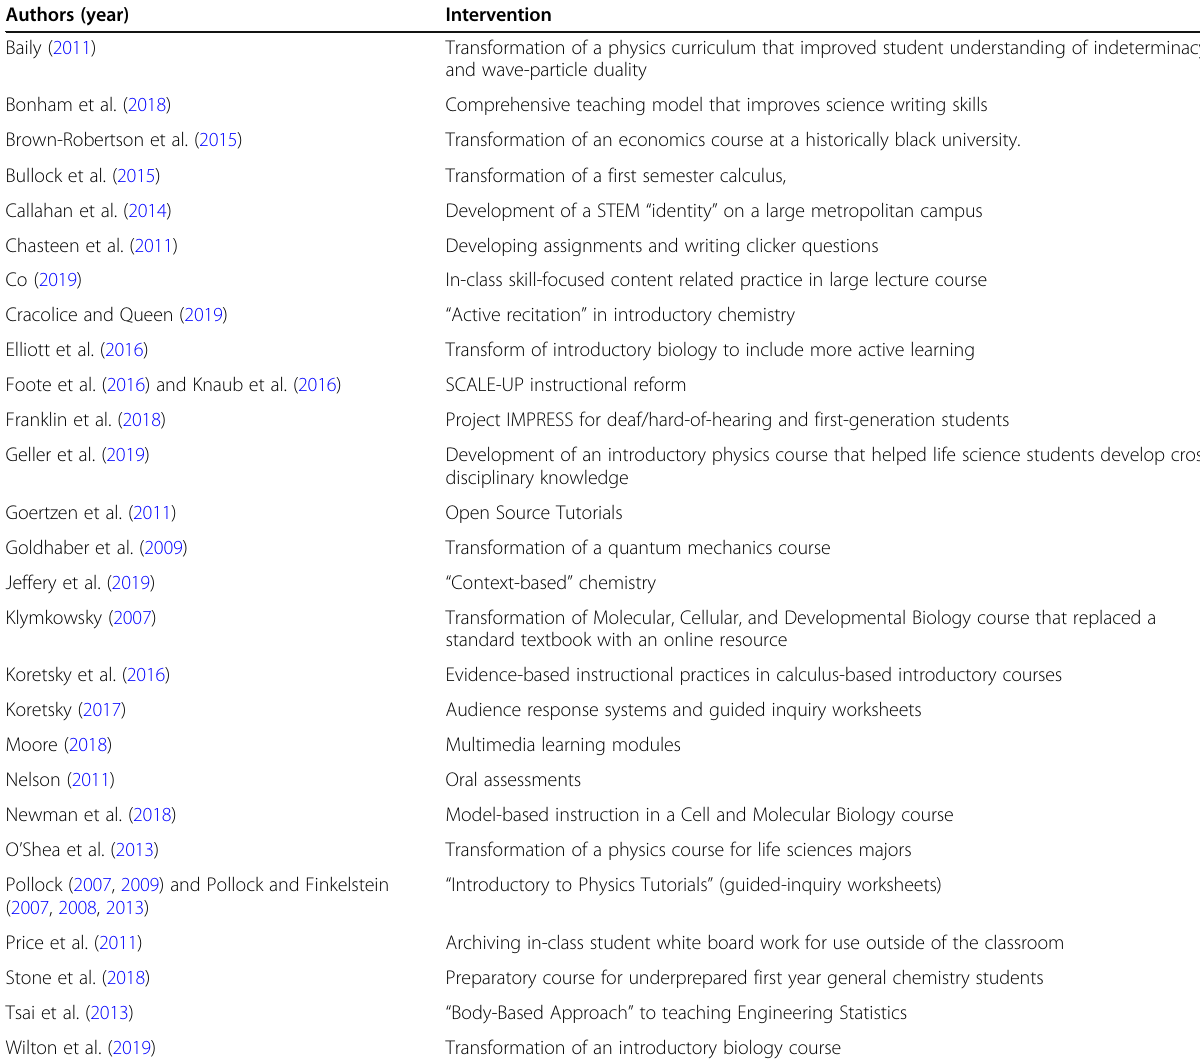
Table 3 Studies that use the LA model, but as only a part of or in addition to another